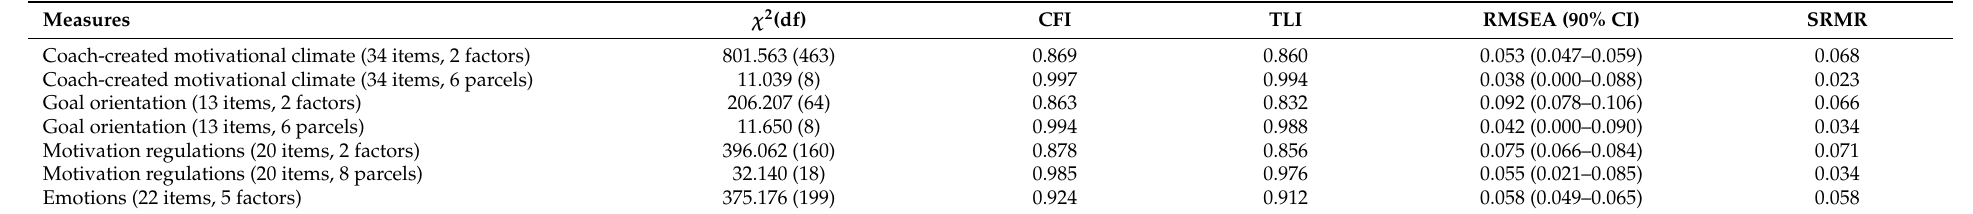
Table 2. Fit indices for each studied variable derived from confirmatory factor